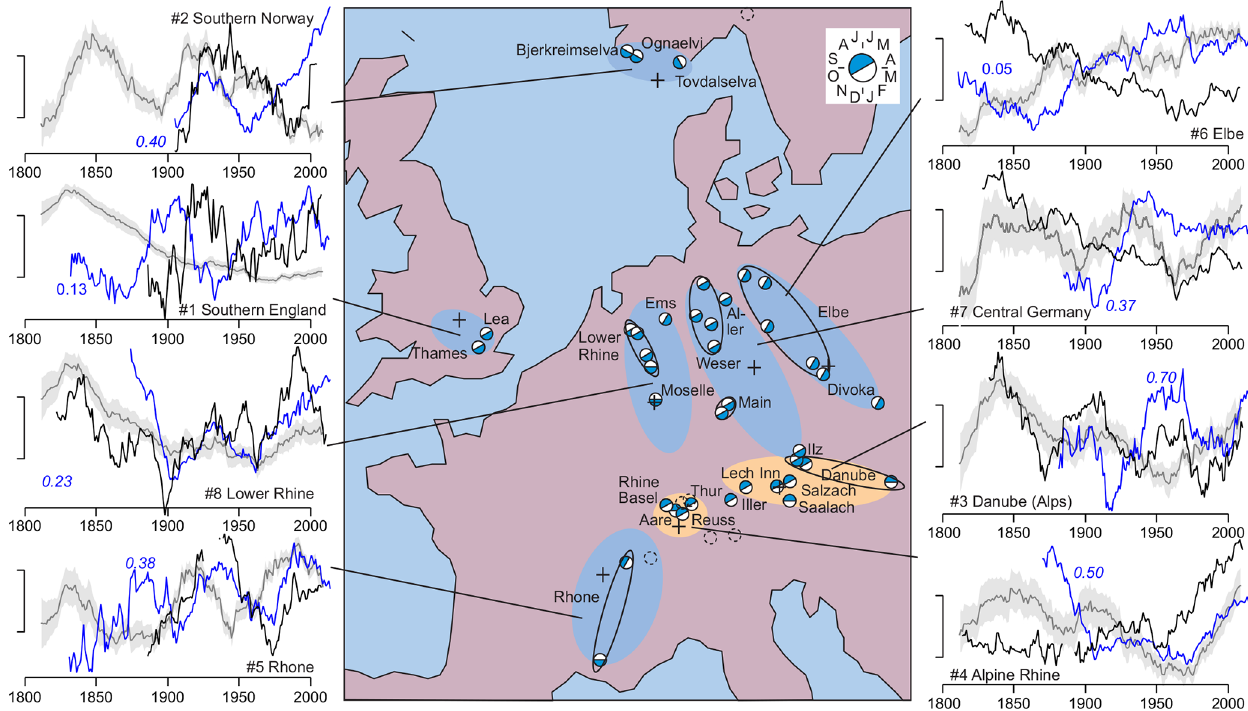
Figure 4. Regionally averaged (coloured ellipses; black ellipses indicate same river) series of normalized peak streamflow (black), Rx5day (blue, the number indicates its correlations with peak streamflow at 4-year aggregation, italics indicates p < 0.05), and CONV5d during the flood season from 20CRv3 at locations of crosses (grey, shading indicates the ensemble standard deviation), standardized and subsequently smoothed with a 30-year moving average (scale bars range from − 0.5 to + 0.5). Regions are colour coded according to the predominance of cold (blue; November to April) or warm season floods (orange; May to October). The blue part of the white-blue circle for each river indi- cates the 6-month period with highest flood frequency. Dashed circles: streamflow series excluded because of likely influence of snowmelt, hydropower dams, or other hydraulic constructions on